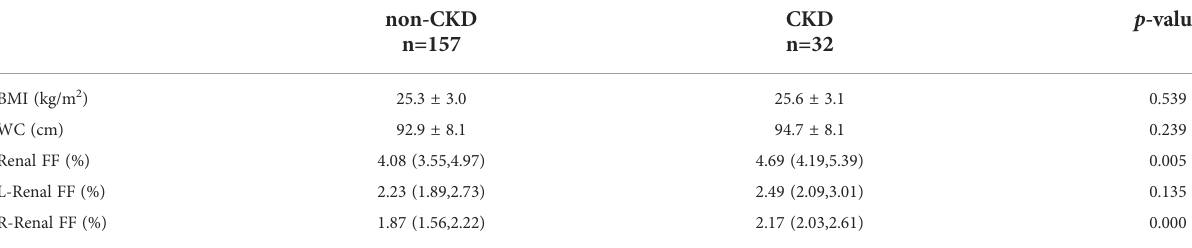
TABLE 2 The differences of BMI, WC and renal FF parameters between non-CKD group (eGFR ≥ 60ml/min/1.73m 2 ) and CKD group (eGFR < 60ml/ min/1.73m 2 ).